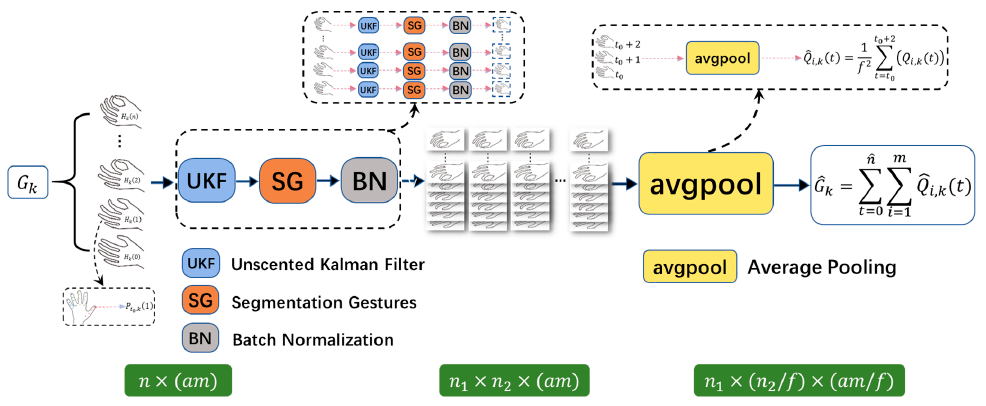
Figure 4. Framework of the data preprocessing.